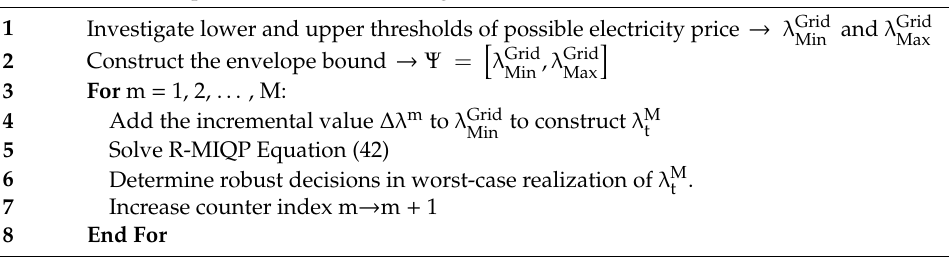
Algorithm 1: Incorporation of robustness region to